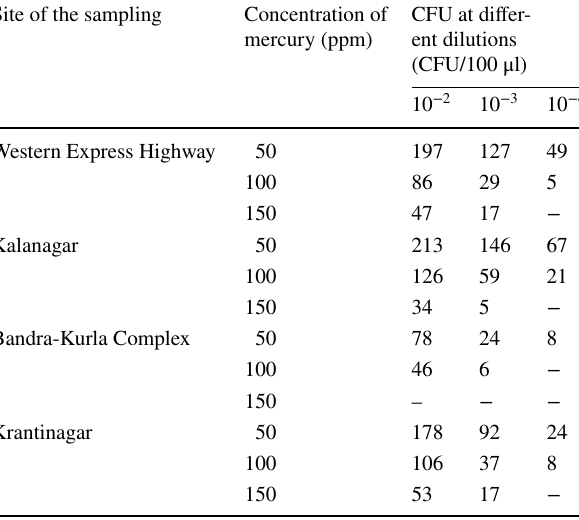
Table 2 CFU of the mercury-resistant bacteria isolated from different sites of Mithi